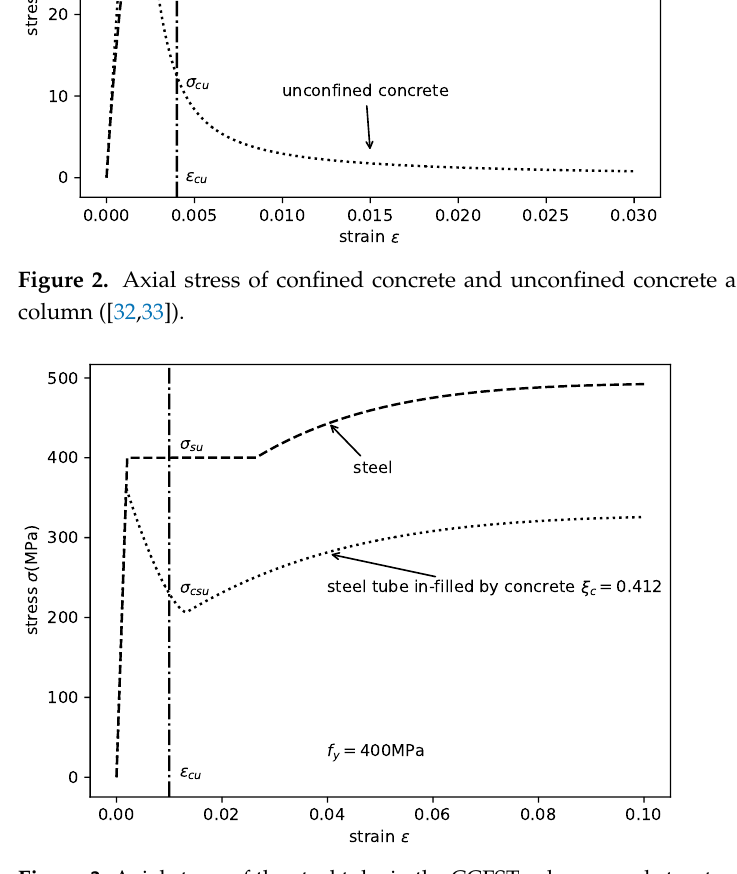
Figure 3. Axial stress of the steel tube in the CCFST columns and structural steel at the ultimate state of the column